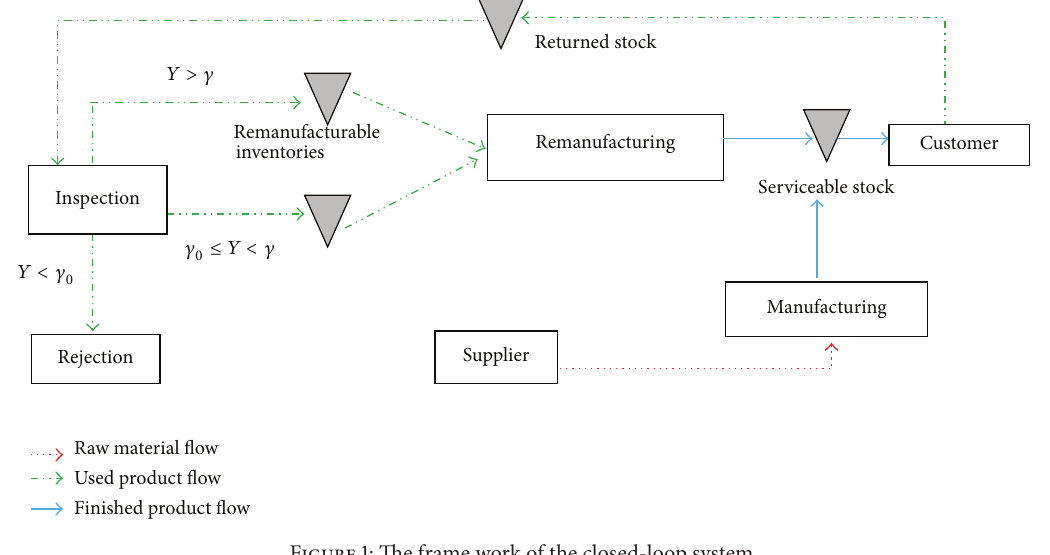
Figure 1: The frame work of the closed-loop